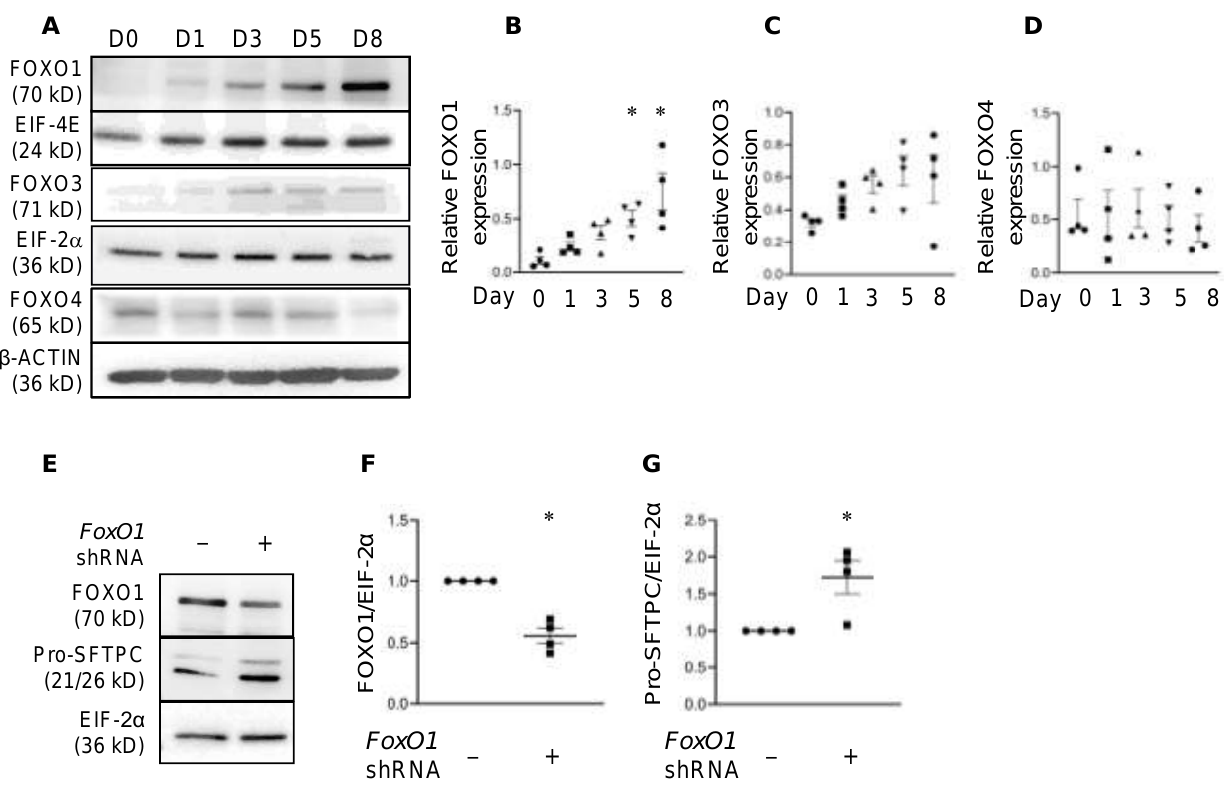
Figure 1. FOXO1 increases in alveolar epithelial cells as a function of time in culture, and knockdown increases expression of the AT2 cell-specific marker SFTPC. Representative Western blot (WB) ( A ) and quantitation ( B – D ) show that the expression of FOXO1, but not FOXO3 and FOXO4, increases as rat AT2 cells (D0) differentiate into AT1-like cells at day eight (D8) in primary culture. EIF-4E, EIF-2 α , and β -ACTIN were the loading controls. n = 4 for each group. One-way ANOVA, asterisk indicates p < 0.05 compared to D0. Representative WB ( E ) and quantitation ( F , G ) show that knockdown of FOXO1 increased pro-SFTPC expression in primary AEC six days following transduction with FoxO1 shRNA (+) or non-silencing shRNA ( − ) on Day two. EIF-2 α was used as the loading control. The data were normalized to non-silencing shRNA. n = 4 for each group. Unpaired two-tailed t -test, asterisk indicates p <0.05.